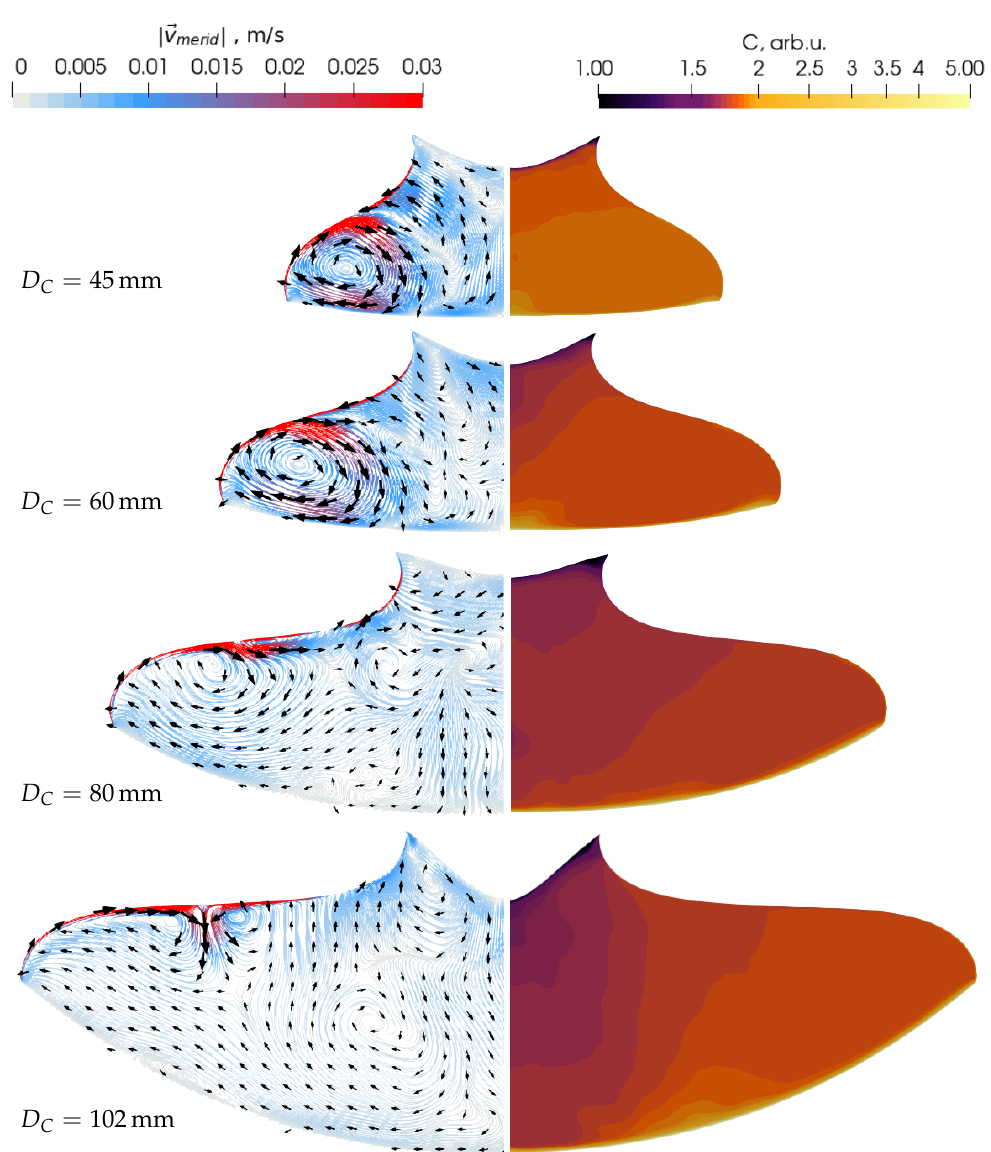
Figure 11. The time-averaged melt velocity ( left ) and carbon concentration ( right ) in the verti- cal cross-section of the melt, simulated for the cylindrical phase ( D C = 102mm) and cone phase ( D C <